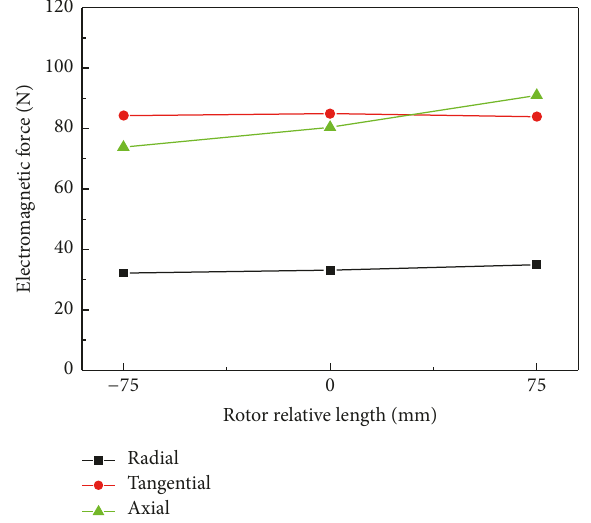
Figure 13: Electromagnetic forces on the nose part with different rotor relative lengths.